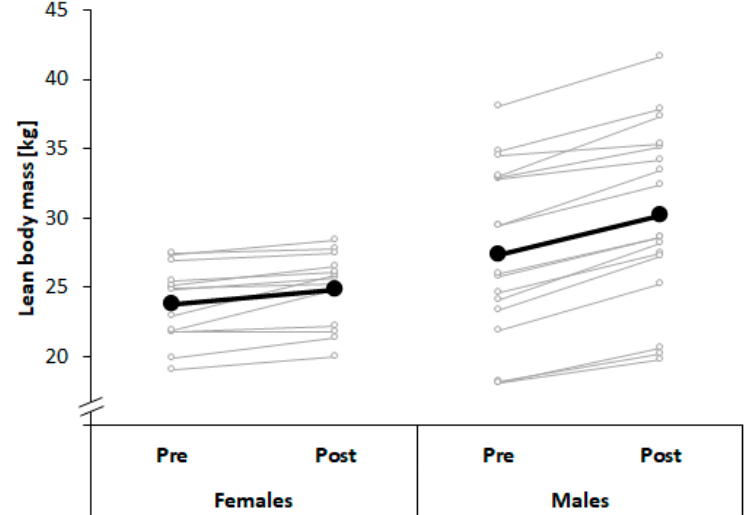
Figure 3. Changes in lean body mass across a period of 10 months of judo training in young male and female judo athletes.